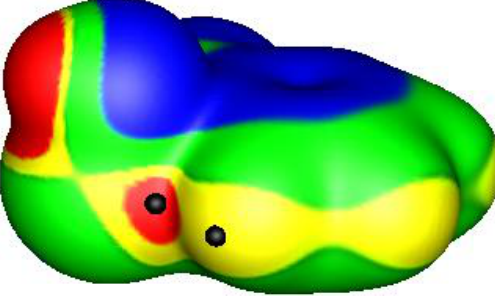
Figure 8. Electrostatic potential of 1-hydroxy-2,1λ 5 -benzoxarsol-3-one, computed at the B3PW91/6-31G(d,p) level on the molecular surface defined by the 0.001 au contour of the electronic density. The structure is shown in Figure 7. The arsenic atom is toward the bottom left, the aromatic ring to toward the right, and the hydroxyl group is pointing up. Color ranges, in volts, are: red, greater than 1.1; yellow, from 1.1 to 0.82; green, from 0.82 to 0; blue, less than zero (negative). One σ-hole is shown on the arsenic, along the extension of the ring oxygen O–As bond; its most positive value is 1.3 V, indicated by a black hemisphere (in red region). The neighboring C–H hydrogen, indicated also by a black hemisphere (in yellow region), has a maximum potential of 1.0